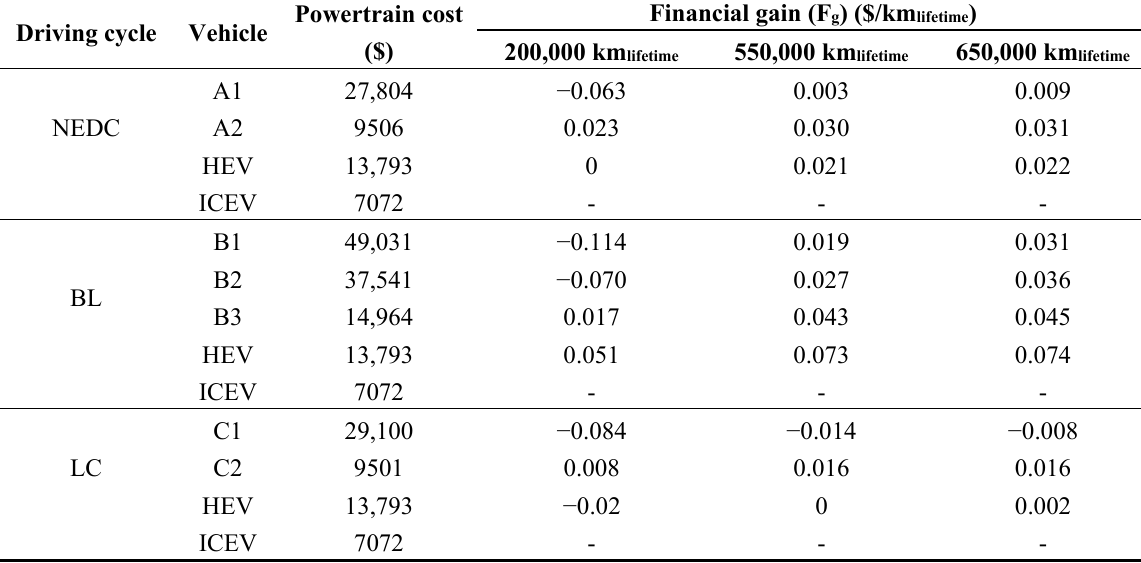
Table 10. Powertrain cost ($) and financial gain ($/km) regarding the optimal solutions and the reference powertrains, for the different driving cycles (NEDC, BL, LC) and lifetime